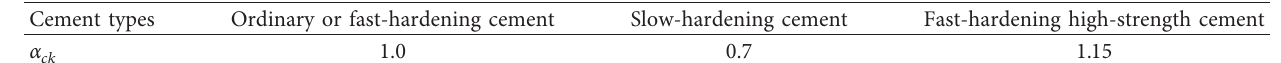
Table 9: Influencing coefficient of cement types on shrinkage [22].